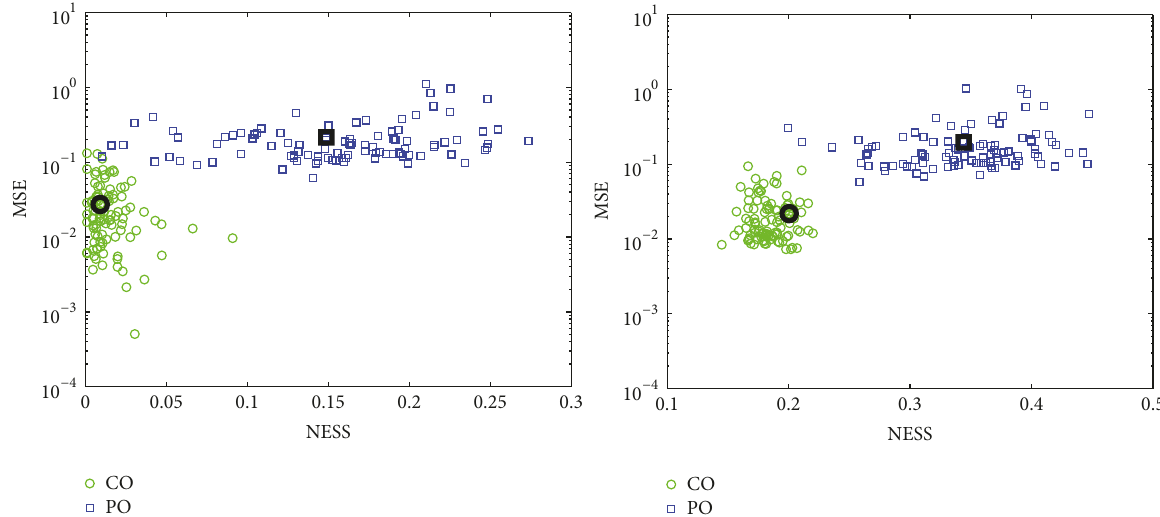
Figure 1: Performance of the pMCMC ( left ) and the NPMC ( right ) methods for the estimation of a unique rate parameter 𝜃 1 : MSE (in logarithmic scale) obtained from the final output versus the NESS for each simulation run in the CO and the PO scenario. The big circles (CO) and squares (PO) represent simulation runs with a final mean MSE close to the global